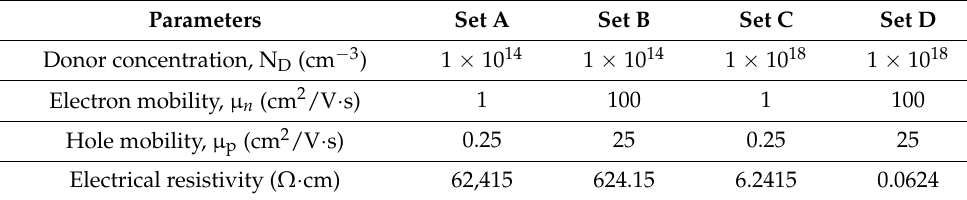
Table 3. Classification of electrical properties of the CdS buffer layer.